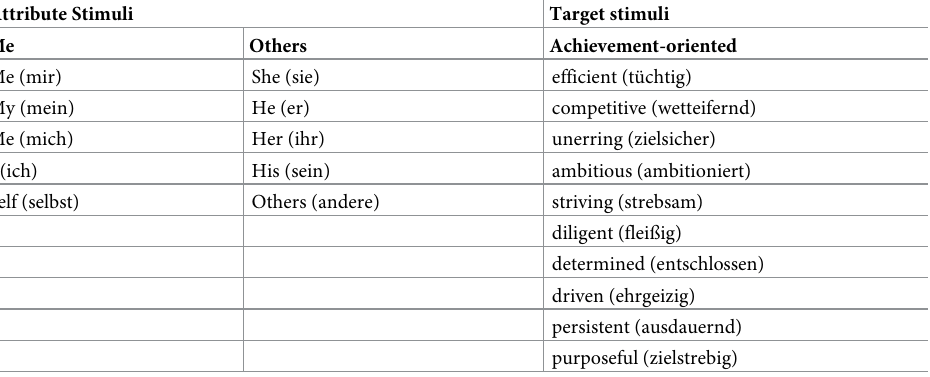
Table 3. Target and attribute stimuli used in the perfectionism SC- IAT. German words that were used in the assessment are provided in